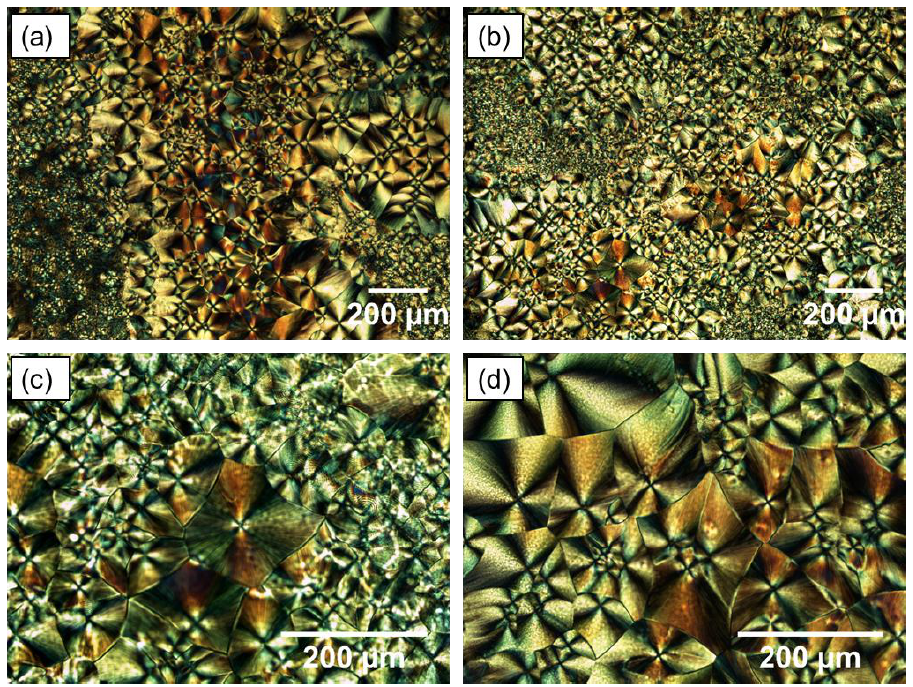
Figure 15. Polarised light microscopy images of UHMWPE. Magnification: ( a , b ) = 4×; ( c , d ) = 10×.